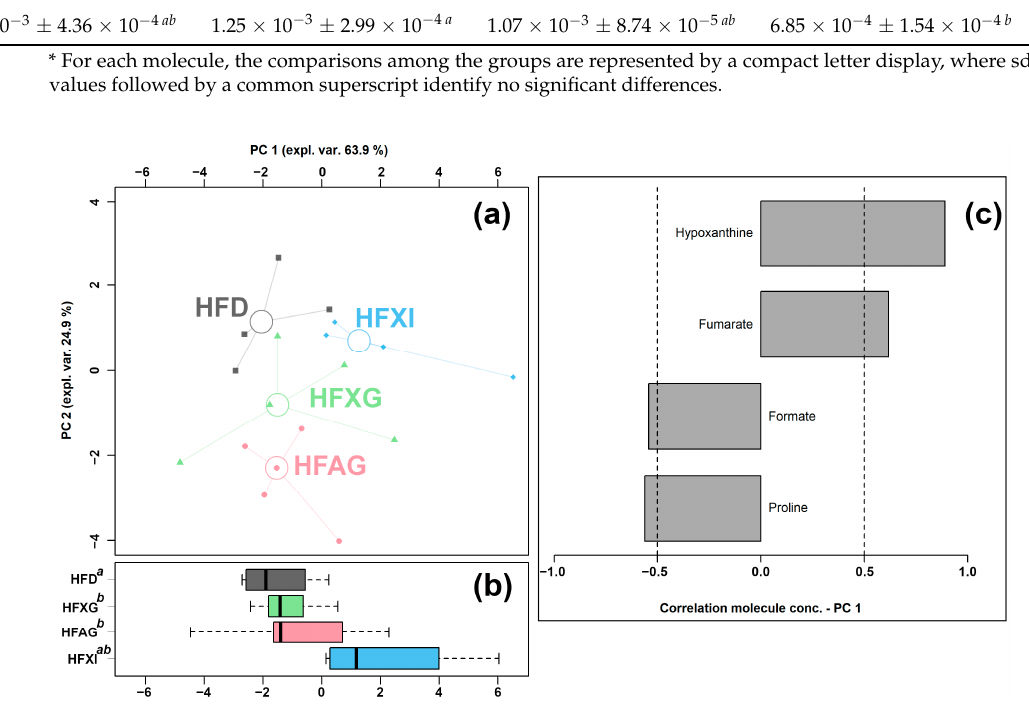
Figure 6. rPCA model was performed on the basis of molecules whose concentrations showed significant differences among HFD, HFAG, HFXG, and HFXI groups. Scoreplot ( a ) shows the overall structure of the data, boxplot ( b ) highlights the position of the samples along PC 1, and loading plot ( c ) shows the significant relationships between the concentration of each molecule and its importance over PC 1 ( p < 0.05).